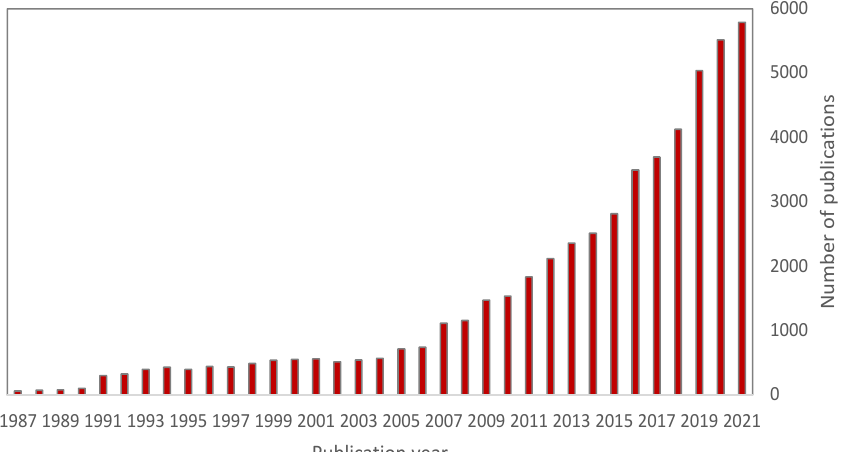
Figure 2. Number of publications in individual years.